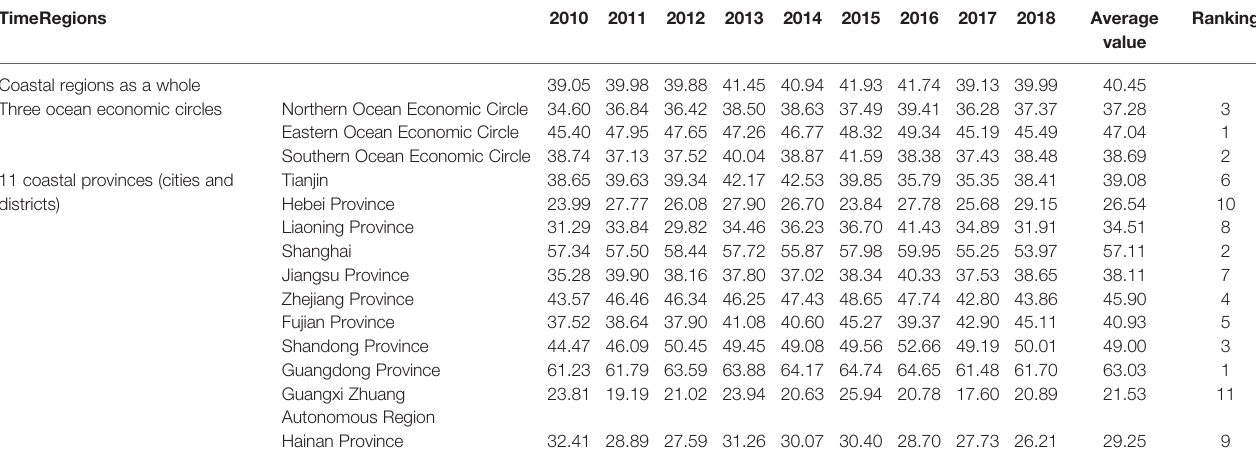
TABLE 2 | Comprehensive scores of the high-quality development level of the regional marine